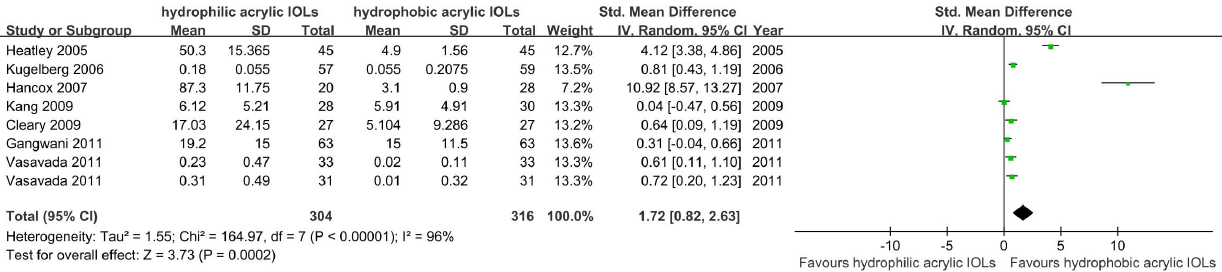
Figure 2. Forest plots describing effects of hydrophobic acrylic versus hydrophilic acrylic IOLs on development of posterior capsule opacification in 1-year follow-up. (Chi 2 = chi square statistic, CI = confidence interval, df = degrees of freedom, I 2 = I-square heterogeneity statistic, IV = inverse variance, SMD = standard mean difference, Z = Z-statistic).